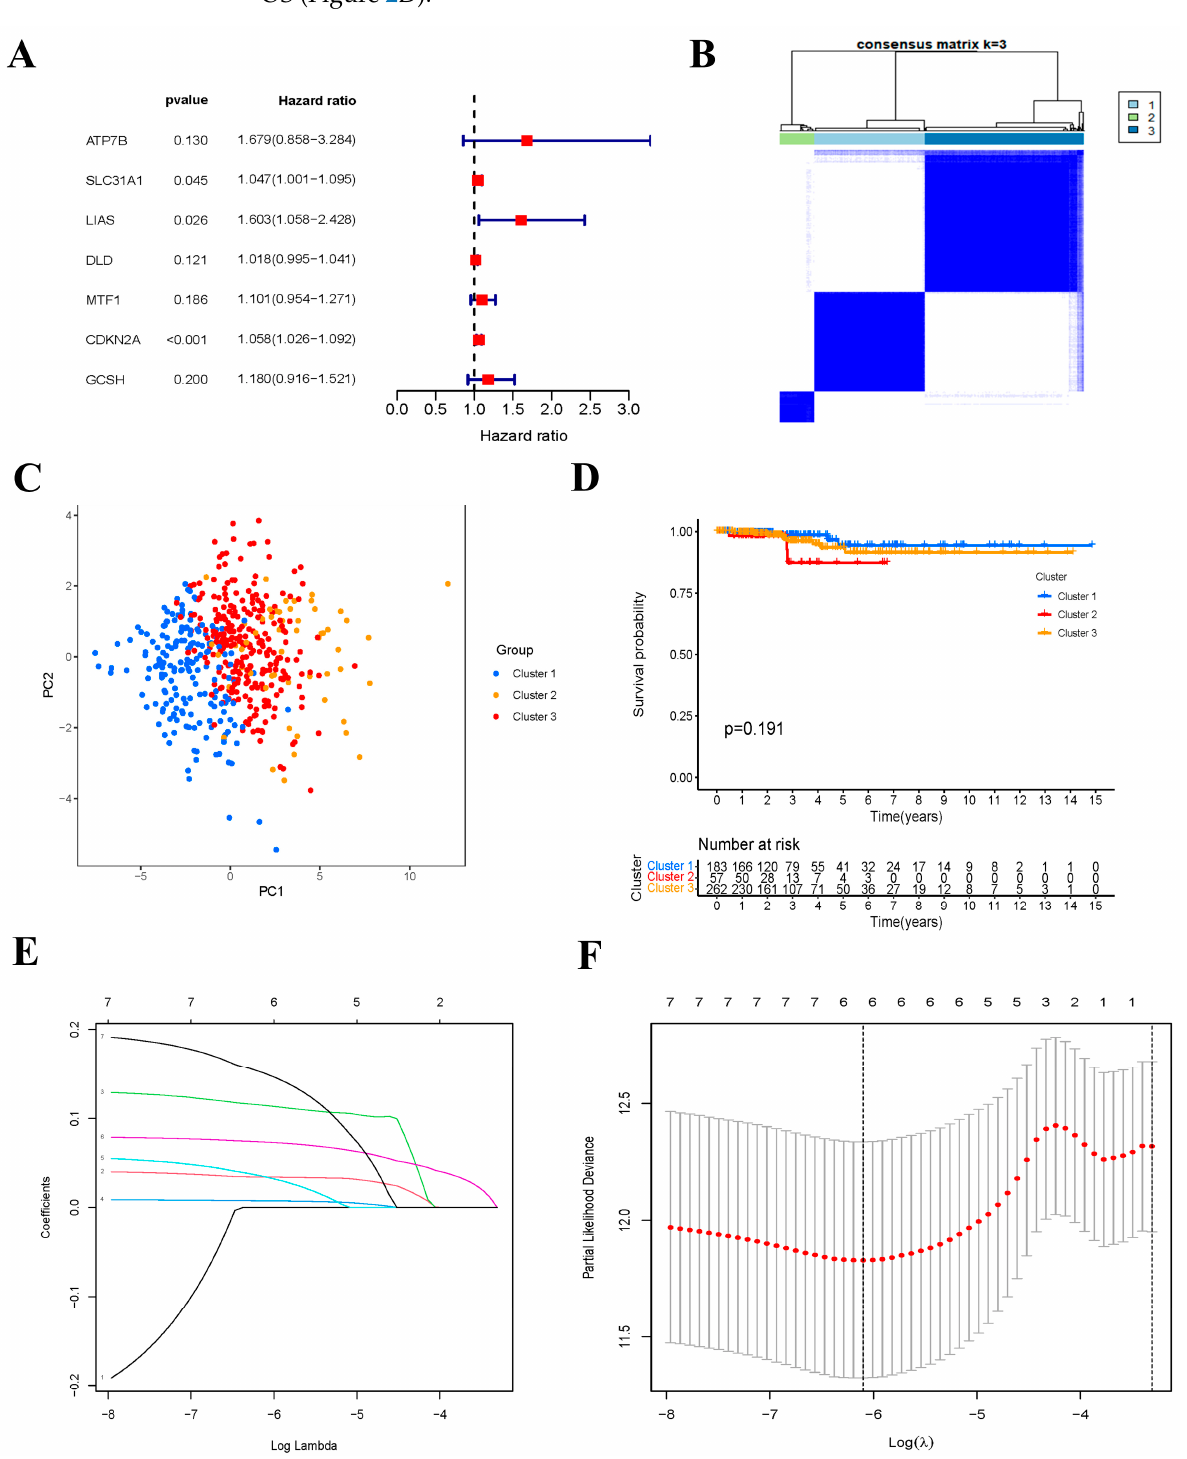
Figure 2. Univariate Cox regression analysis, identification of consensus clusters based on the cuproptosis-related genes and LASSO analysis. ( A ) Forest plot showing the result of univariate Cox regression analysis of OS, seven genes with p < 0.2. ( B ) Consensus clustering matrix for k = 3. ( C ) Principal Component Analysis (PCA) of the RNA expression profile in TCGA cohort. ( D ) Kaplan– Meier curves of overall survival (OS) in three clusters. ( E ) Cross-validation for tuning parameter selection in the LASSO regression. ( F ) LASSO analysis of seven prognostic cuproptosis-related genes.